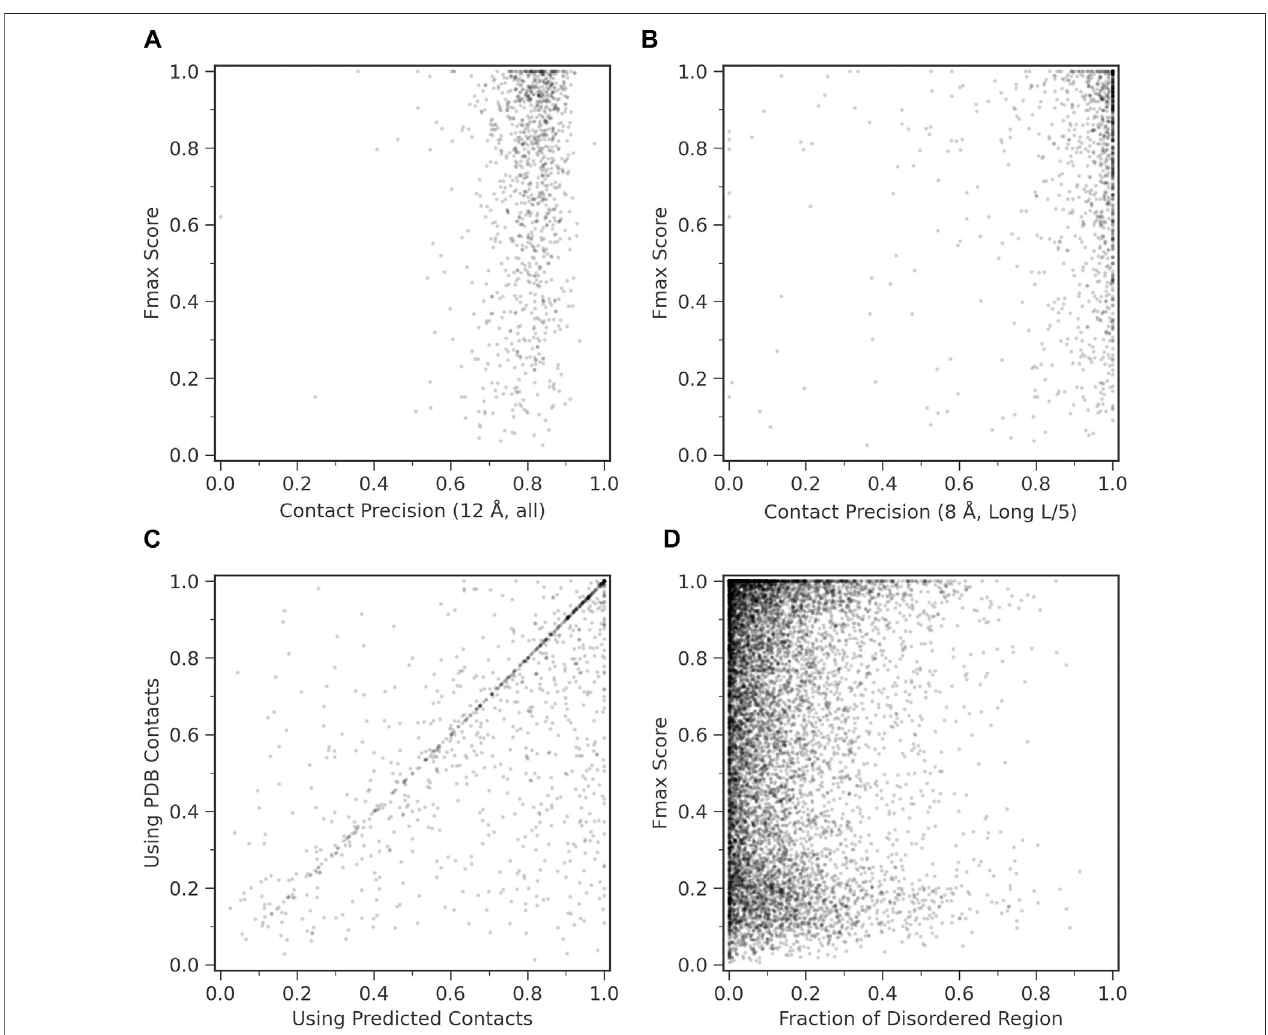
FIGURE4| Functionpredictionaccuracyrelativetostructuralfeaturesoftargetproteins. (A) and (B) ,FmaxscoreofContactPFPrelativetotheprecisionofcontact prediction.Eachpointiscorrespondingtoaproteinwhichhasanexperimentallydetermined structure.Therewere1,029proteinsofthem. (A) Fmaxscorerelative tothe precision of all predicted contacts. Contacts are de fi ned for residue pairs that have a C β distance within 12 (cid:1) A from each other. The average precision was 0.801. (B) Fmax score relative to the precision when we considered the top L/5 predicted long-range contacts, which were de fi ned as contacts that are 24 residues or more apart on the sequence. L is the length of a protein. Contacts were de fi ned as residue pairs that have their C β atoms placed within 8 (cid:1) A. The average precision L/5 long precision was 0.908. (C) Comparison of the performance between ContactPFP using predicted contacts and ContactPFP that uses accurate contacts taken from the experimentallydeterminedstructures.Contactsarede fi nedforresiduepairsthathaveC β atomswithin12 (cid:1) Afromeachother.Fmaxscoresofthe1,029targetsthathave PDB structures were compared. (D) The effect of the fraction of disordered regions in proteins to the Fmax score. We used fl dpnn to predict residues in disordered regions.